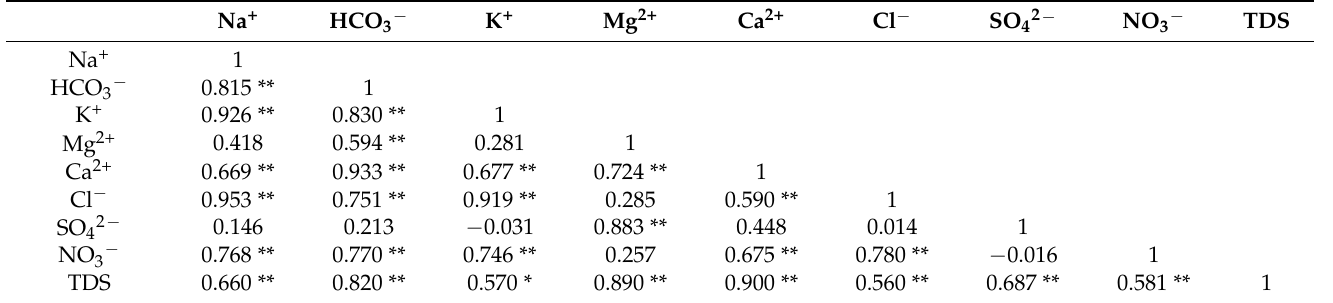
Table 2. Correlation coefficients among various water chemical parameters of the natural water.